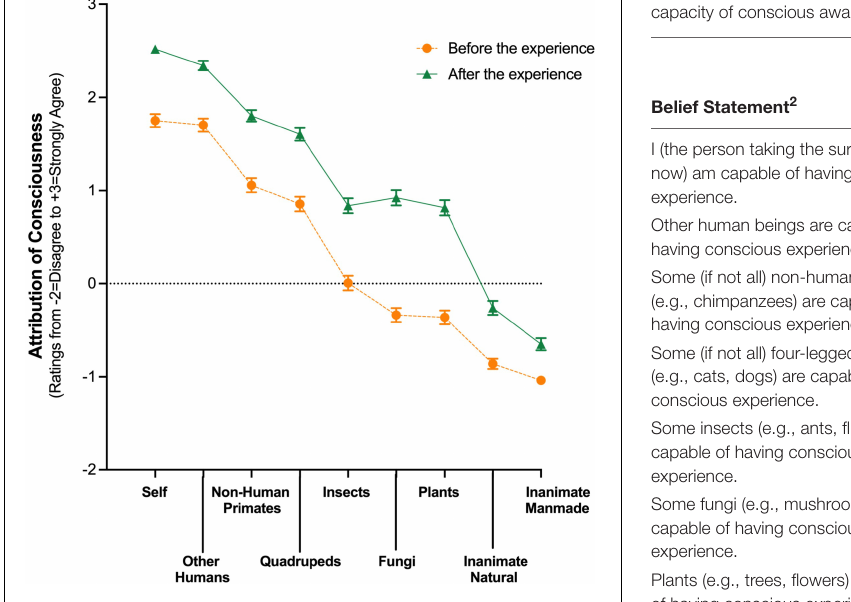
FIGURE 1 | Attribution of consciousness to living and non-living entities before and after a psychedelic belief-changing experience. Y axis: Rating of agreement with the belief that the entity has capacity for conscious awareness from Disagree (–2) to Strongly agree (+3), with Neither agree nor disagree (0) indicated by dotted line. X axes: categories of living and non-living entities. Data are means ( ± 1 SD with yellow circles indicating ratings before and green triangles indicating after the experience. All differences from “Before” to “After” the experience met statistical and effect size criteria for being meaningfully different ( Supplementary Material ).